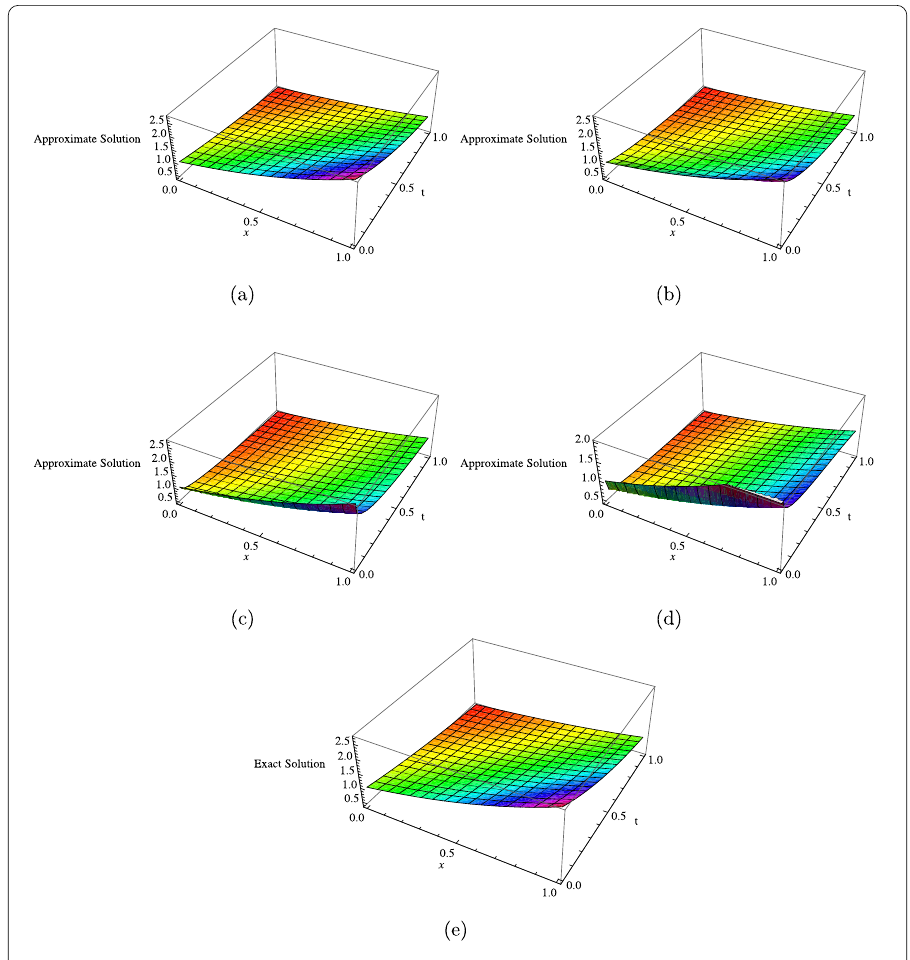
Figure 1 The 4th-order approximate solution of the TFNWS equation: ( a ) η 4 ( x , t ) when β = 1. ( b ) η 4 ( x , t ) when β = 0.75. ( c ) η 4 ( x , t ) when β = 0.5. ( d ) η 4 ( x , t ) when β = 0.25. ( e ) Exact solution u ( x , t ) when β =